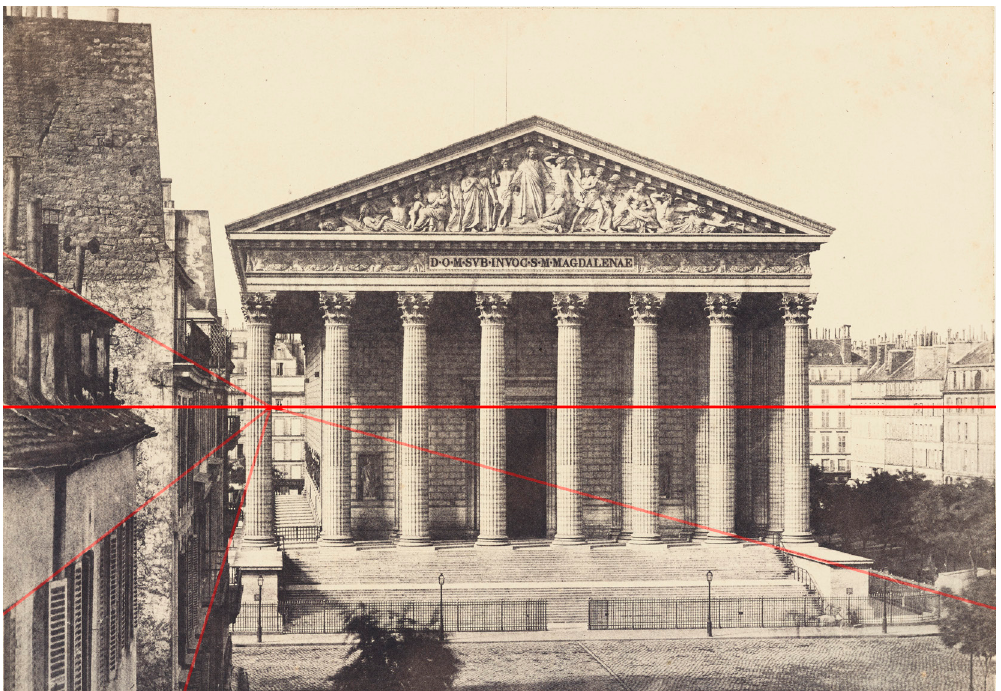
Fig. 4 Henri Le Secq, Louis Désiré Blanquart-Evrard, Church of